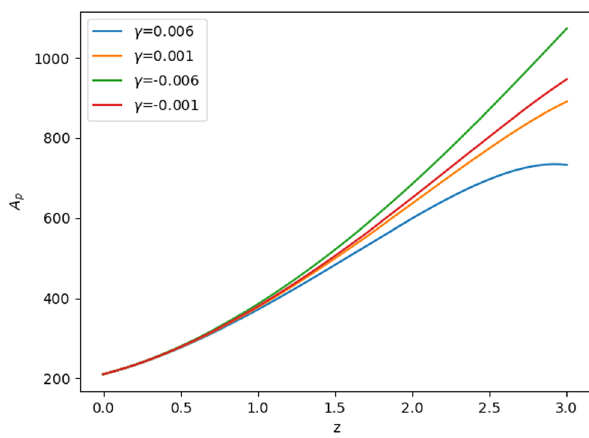
Figure 6: The evolution of the anisotropy parameter in